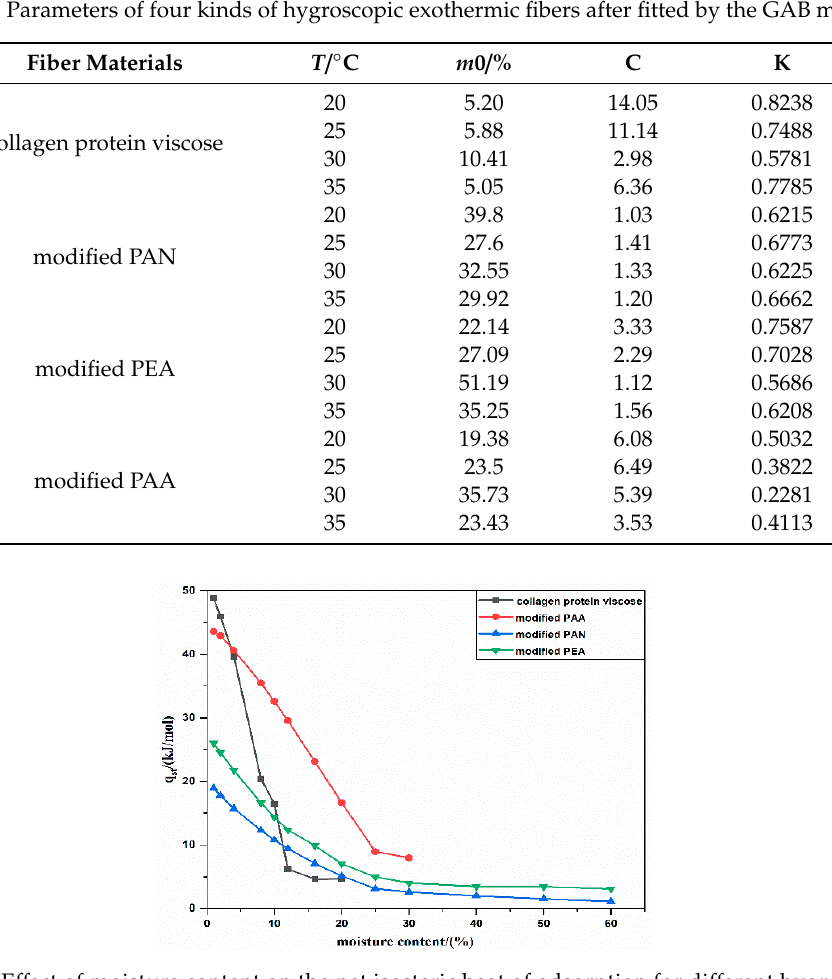
Figure 6. E ff ect of moisture content on the net isosteric heat of adsorption for di ff erent hygroscopic Figure 6. Effect of moisture content on the net isosteric heat of adsorption for different hygroscopic exothermic exothermic fibers.